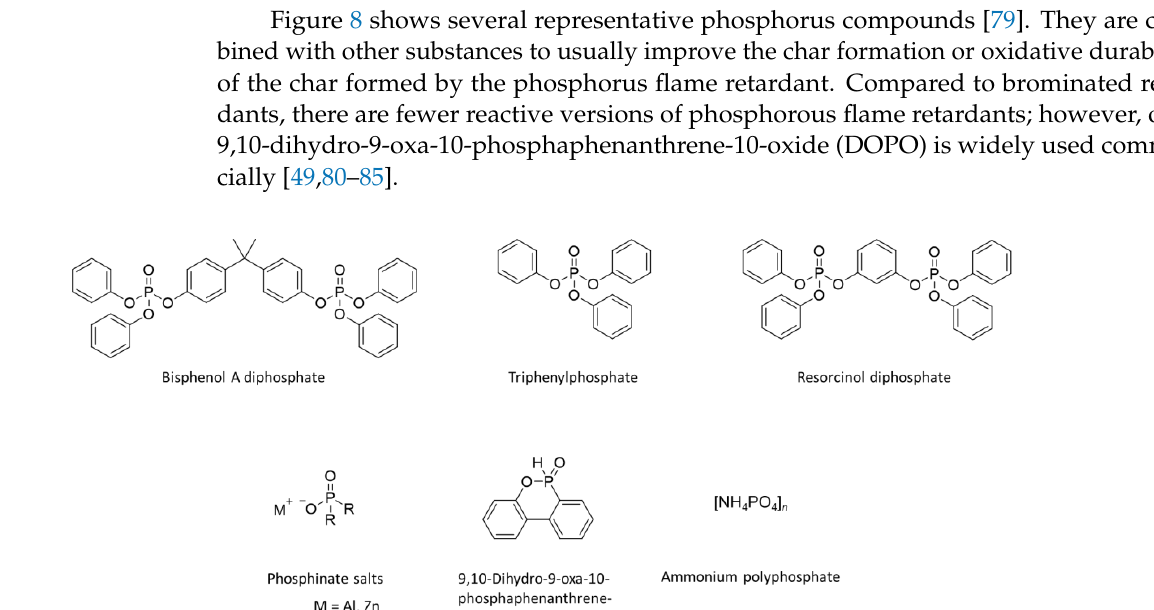
Figure 7. Representative chemical structures of bromine-containing flame retardants that have an inhibitory effect on combustion chemistry. Reprinted with permission from Ref. [49]. Copyright 2012, John Wiley & Sons, Ltd.